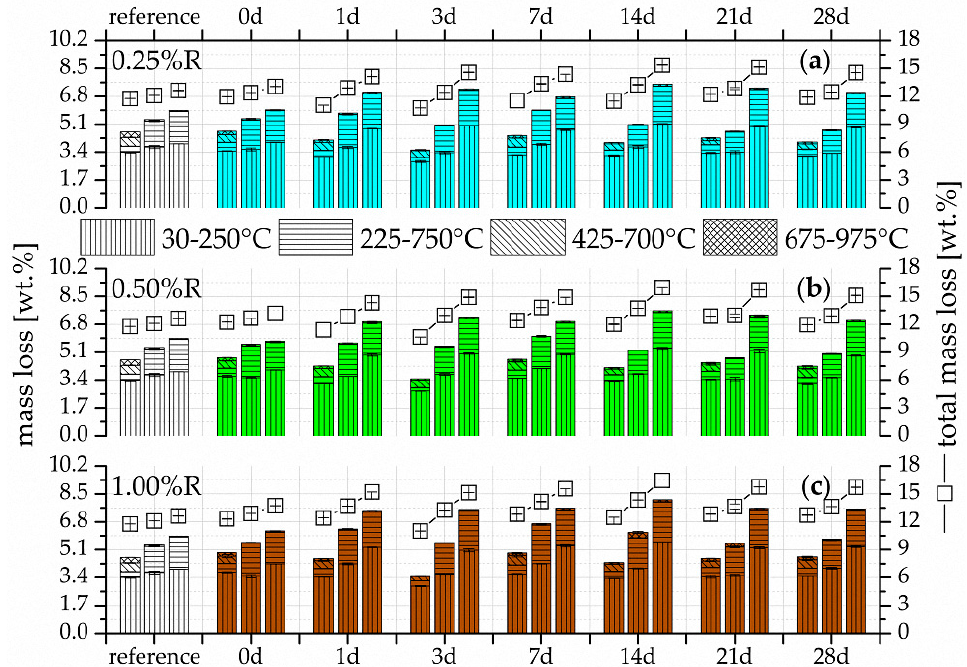
Figure 4. Mass loss by TG of Ac2 after seven, 28 and 90 days (from left to right per test) after the beginning of the hydration of the reference of Ac2 (without retarder) and the reactivated mixtures with NaOH after seven different periods of retardation with ( a ) 0.25%; ( b ) 0.50%; and ( c ) 1.00%R.